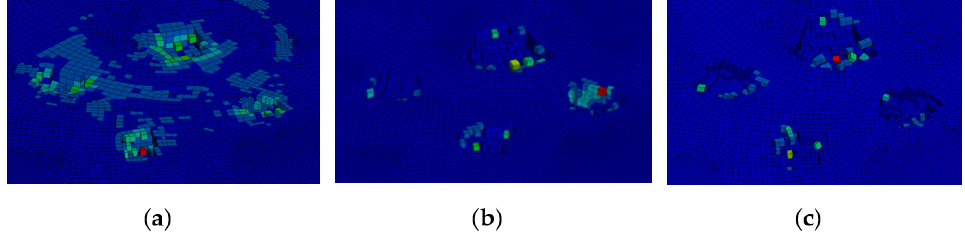
Figure 12. Lunar rocks crushing simulation results ( a ) 0.16 ms; ( b ) 1 ms; ( c ) 2 ms.